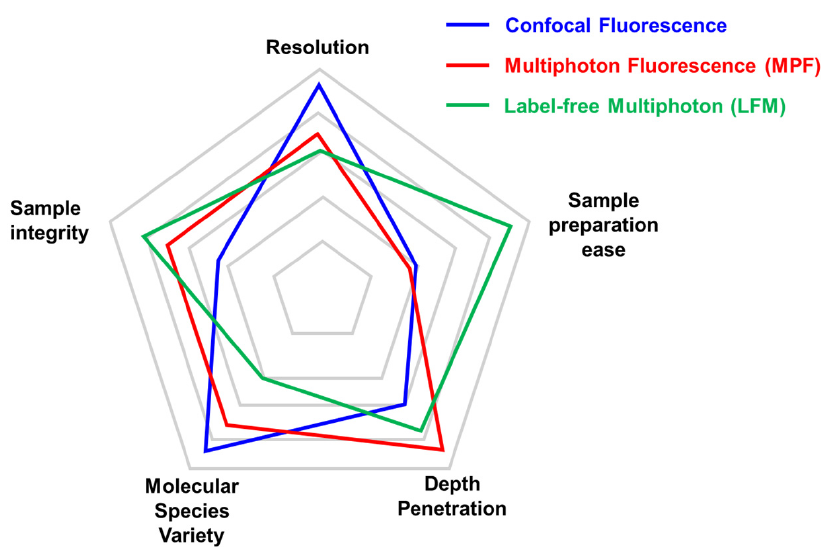
Figure 1. Comparison of key parameters of different imaging techniques. Each microscopy technique has strengths and weaknesses that are important to consider before choosing the adequate microscopy approach. We limited the radar plot to five parameters (Resolution, Sample preparation ease, Depth penetration, Molecular species variety, and Sample integrity), although experimental needs may require considering other aspects (i.e., acquisition speed). The relative performance of confocal microscopy (in blue), multiphoton (in red), and label-free multiphoton (in green) are compared with the outer position indicating the best performance for that parameter. The same set-up can be optimized for specific approaches (multiphoton fluorescence vs. label-free mul- tiphoton).